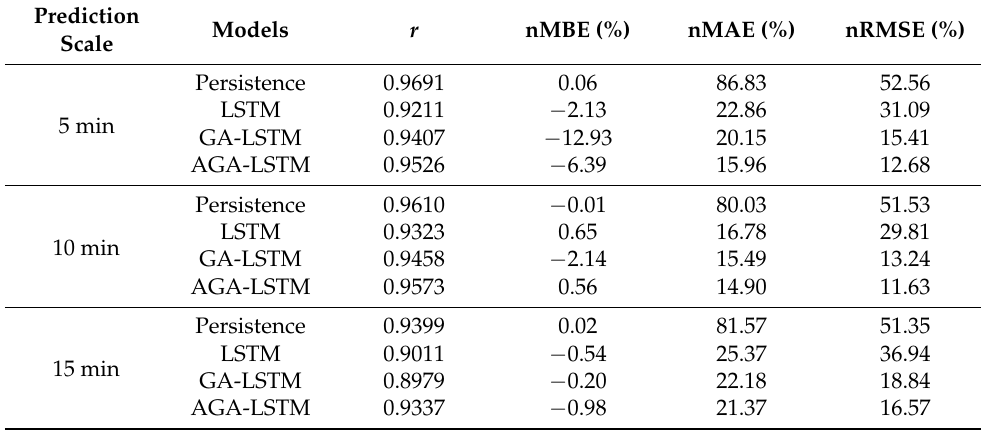
Table 4. The performance of the AGA-LSTM model for predicting DNI.